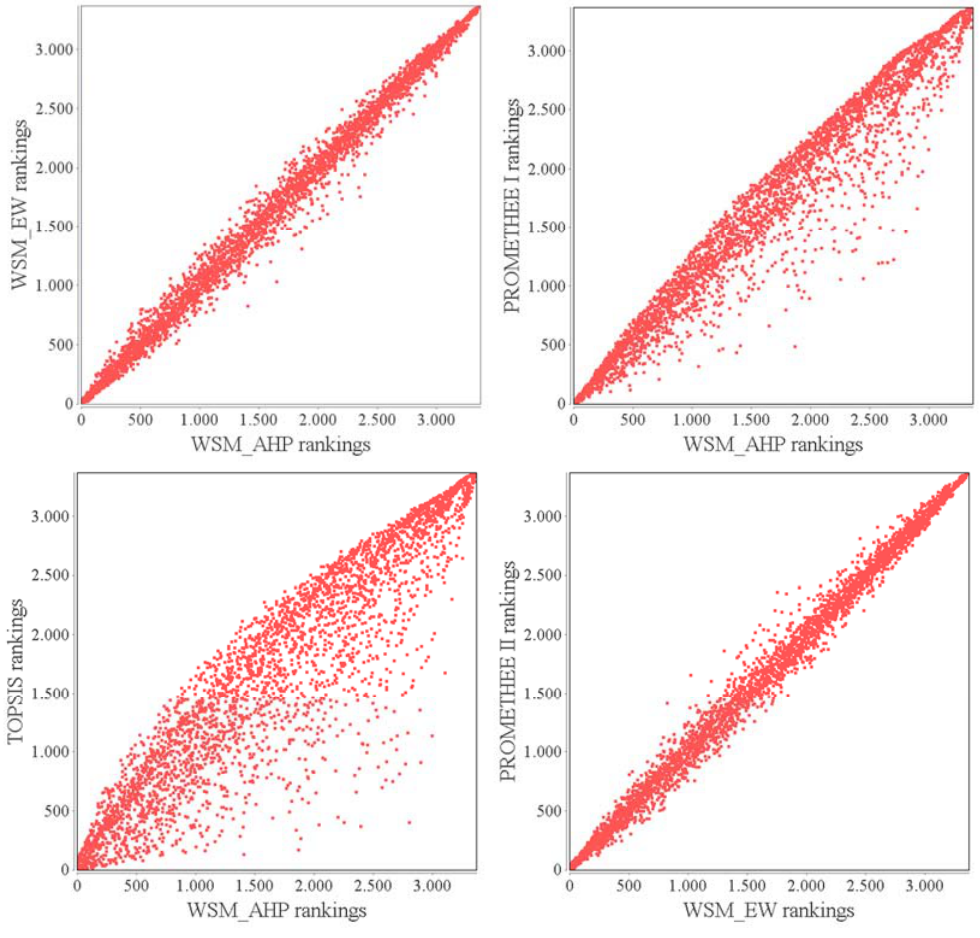
Figure 6. Ranking scatterplots.